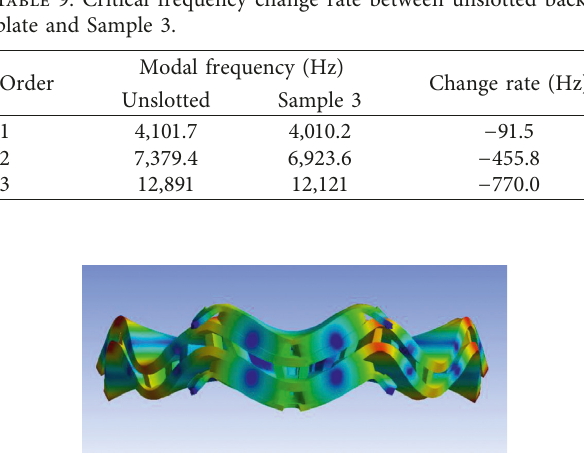
Figure 13: Unstable vibration mode at the braking pressure of 2.0 MPa (at